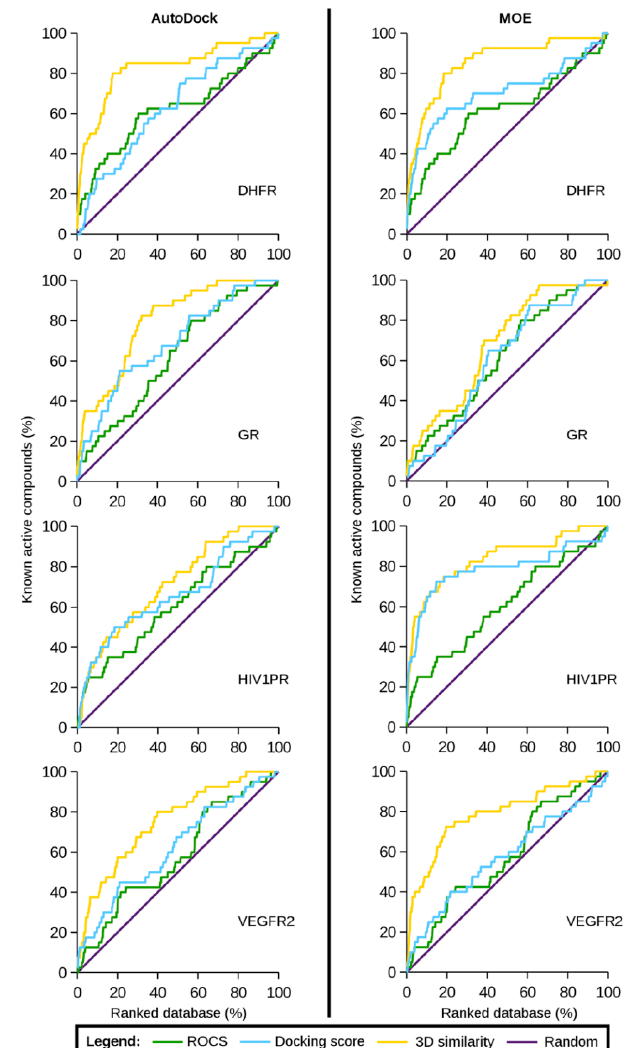
Figure 7. ROC plots obtained for four validation targets (DHFR: dihydrofolate reductase, GR: glucocorticoid receptor, HIV1PR: HIV-1 protease, and VEGFR2: vascular endothelial growth factor receptor-2) using shape-based similarity (ROCS; green), docking (AutoDock [166] and MOE [167]; cyan), and the hybridized method (yellow). Reprinted with permission from the American Chemical Society